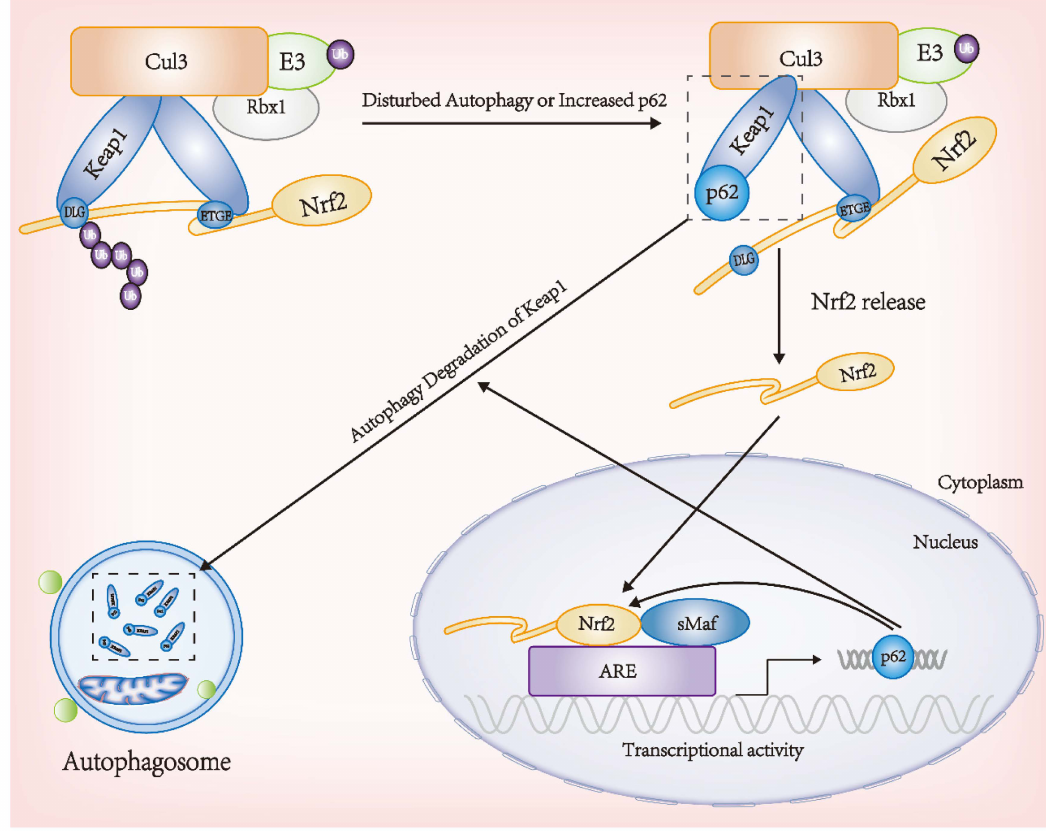
Figure 4. Crosstalk between Nrf2 and autophagy. 5. Crosstalk between Nrf2 and Autophagy in Ischemic Cerebrovascular